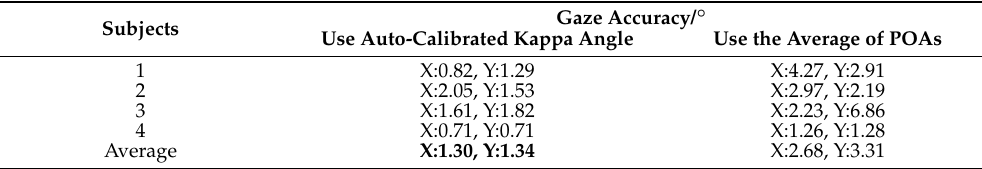
Table 6. Gaze accuracy of different